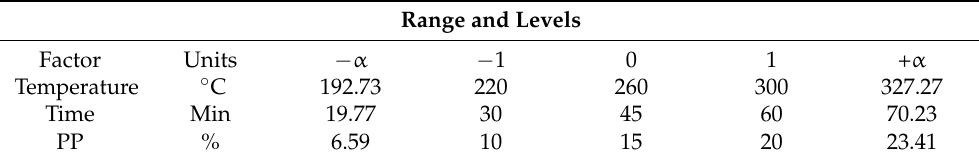
Table 7. Factor levels for the co-torrefaction of fungal bran (FB) and polypropylene (PP). Range and